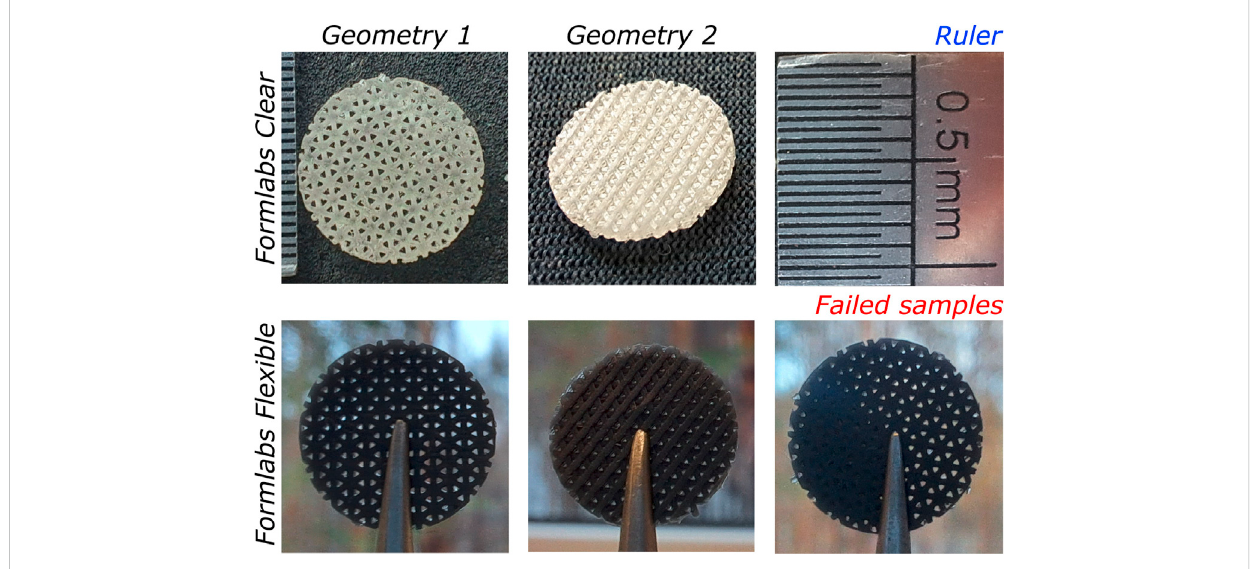
FIGURE 3 Images of 3D-printed scaffolds used for biocompatibility evaluation: Geometry 1 (left) and Geometry 2 (centre) made of Clear (top) and Flexible (bottom) resin. Also, an example of a failed sample (bottom right).